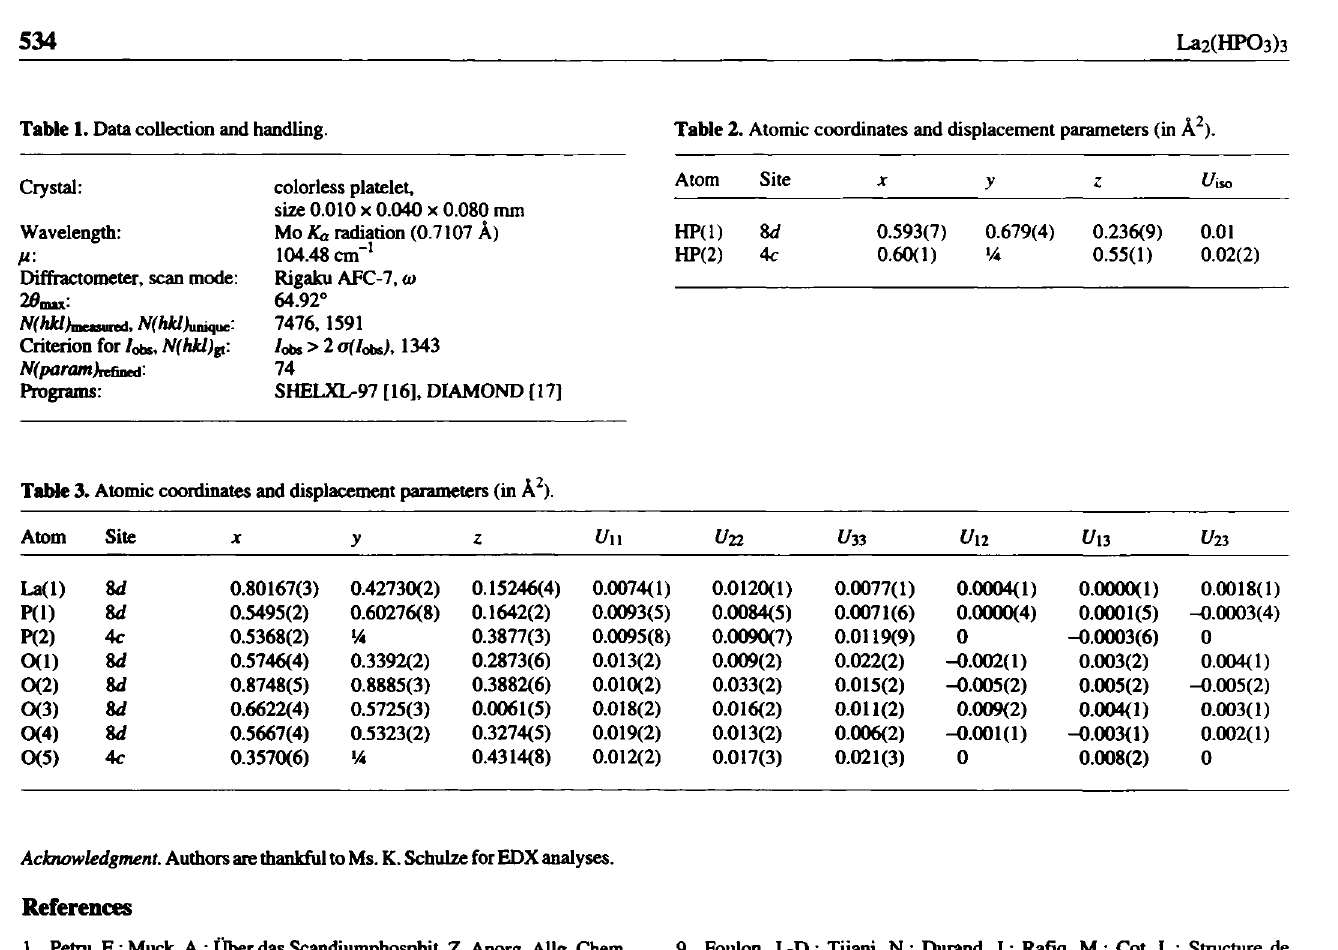
Table 3. Atomic coordinates and displacement parameters (in Ä 2